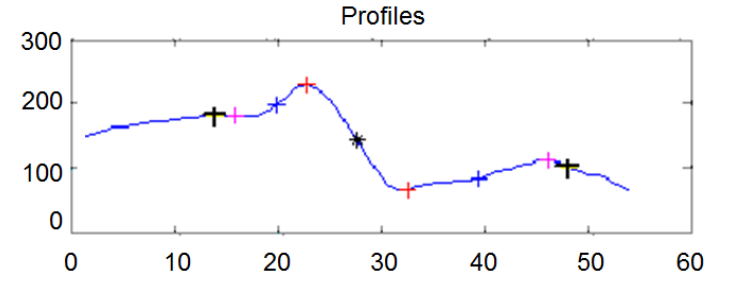
Figure 4. Obtaining of the ends points of the